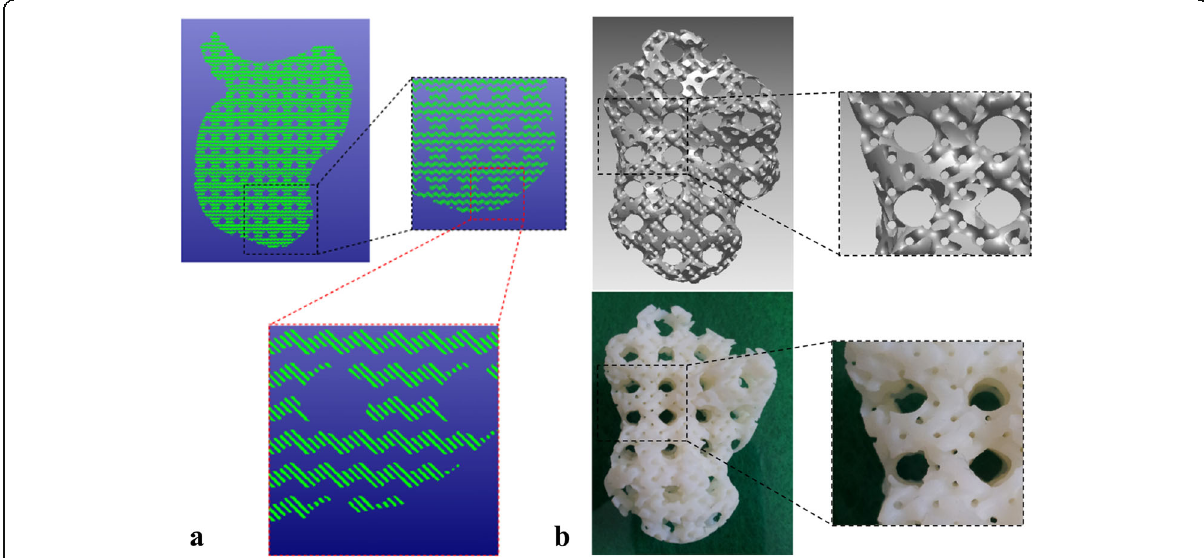
Fig. 13 Hierarchical TPMS scaffold design: a Macrostructure, mesostructure and microstructure. b Manufacturing result by 3D printing